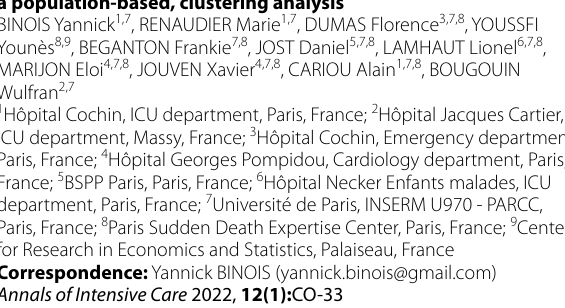
CO‑33 Factors associated with circulatory death after cardiac arrest: a population‑based, clustering